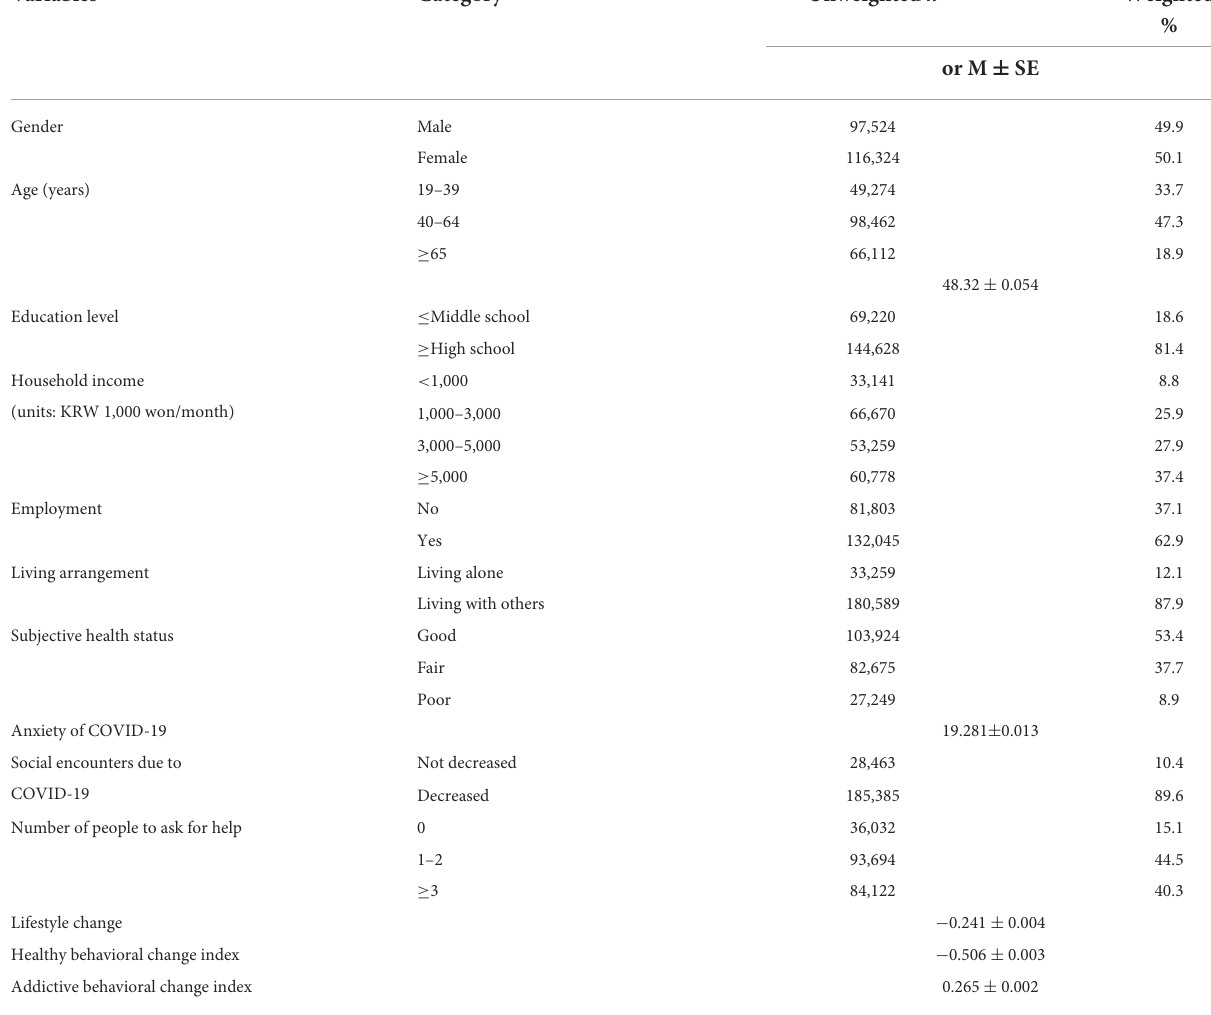
TABLE 1 General characteristic and social factors of the participants ( N = 213,848).